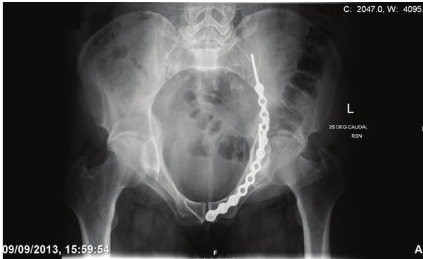
Figure5:Aninletviewofthepelvistohighlighttheplatecontouring